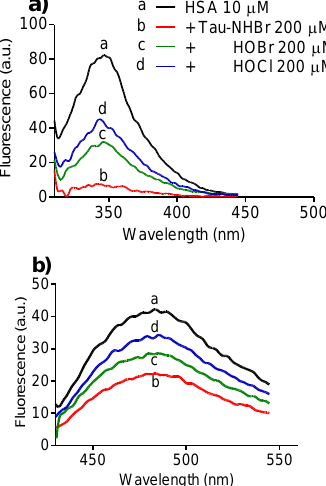
oxidizable polyphenol, as the target. The rate constants were 7.3 M −1 s −1 and 38.2 M −1 s −1 for Tau-NHCl and Tau-NHBr, respectively (Figure 7).